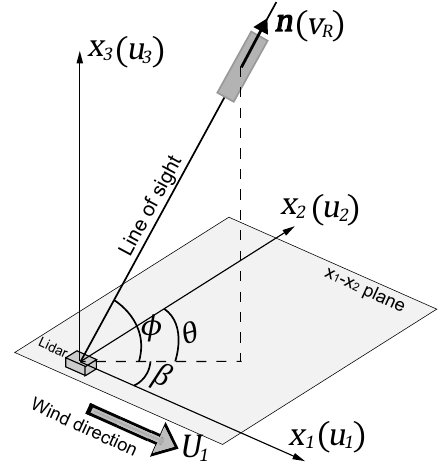
Figure 1. The schematic of lidar line of sight (LOS) orientation in the streamline coordinate system